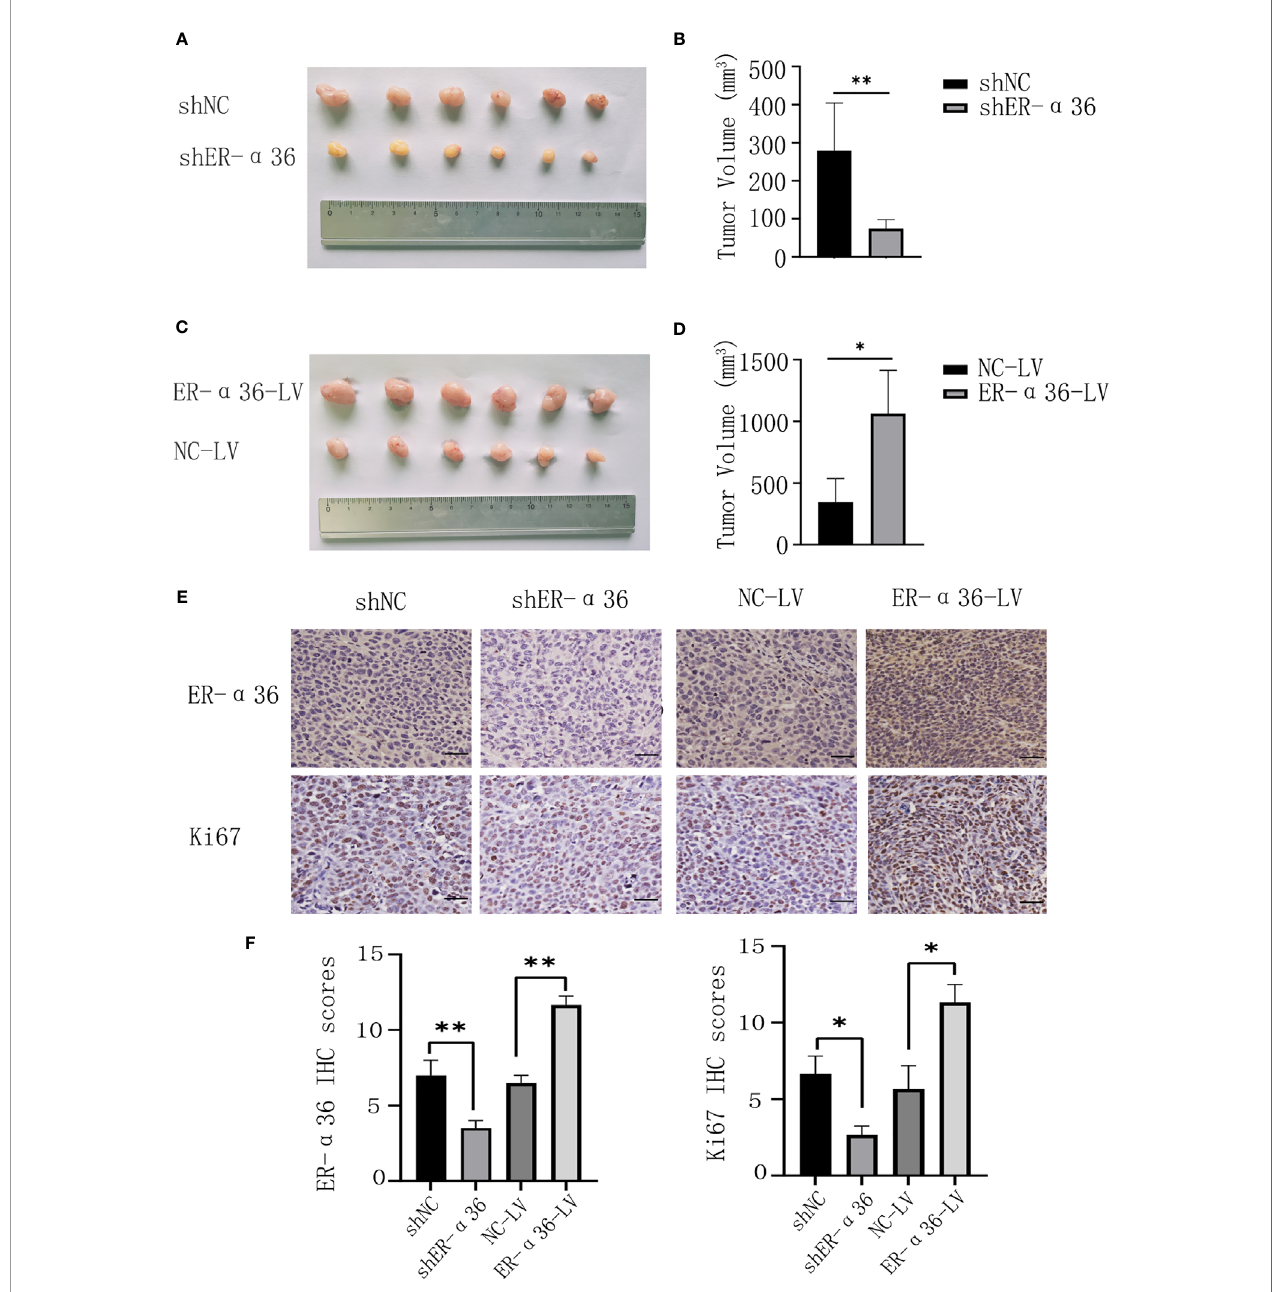
FIGURE 5 | The role of ER- a 36 in the oncogenic function induced by E 2 in vivo . (A, C) Image of xenograft tumors. (B, D) Tumor volumes of each group. (E) Representative images of IHC staining of ER- a 36 and Ki67 in tumor tissues. (F) IHC scores of each group. Scale bar: 50 µm (Data are mean ± SEM, *p < 0.05, **p < 0.01, n =